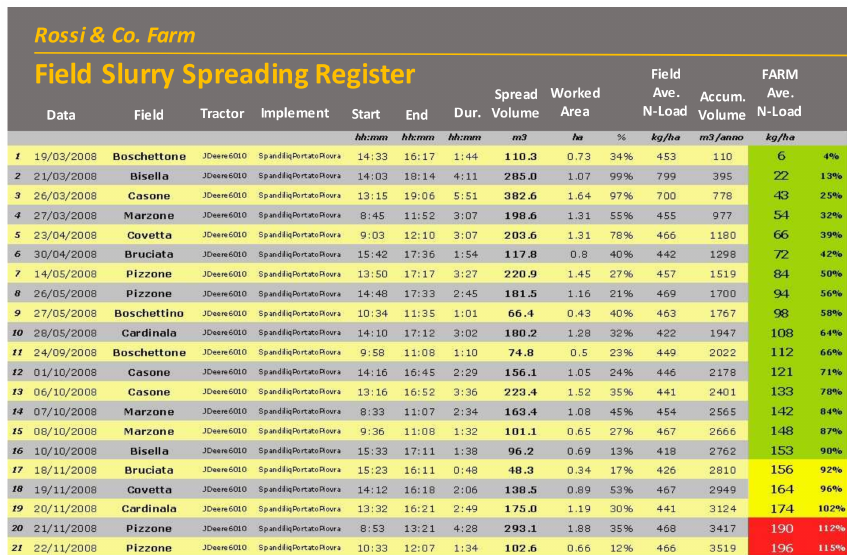
Figure 13. Example of yearly report obtained by combining information from di ff erent sources of automated operational monitoring applications (slurry levels in tank, and field slurry spreading registers, as part of a FORK monitoring system). The farm at hand, being in a vulnerable area, is subject to a N-load limitation of 170 kg / (h · year). Such integrated system provides early warning when limit values are going to be